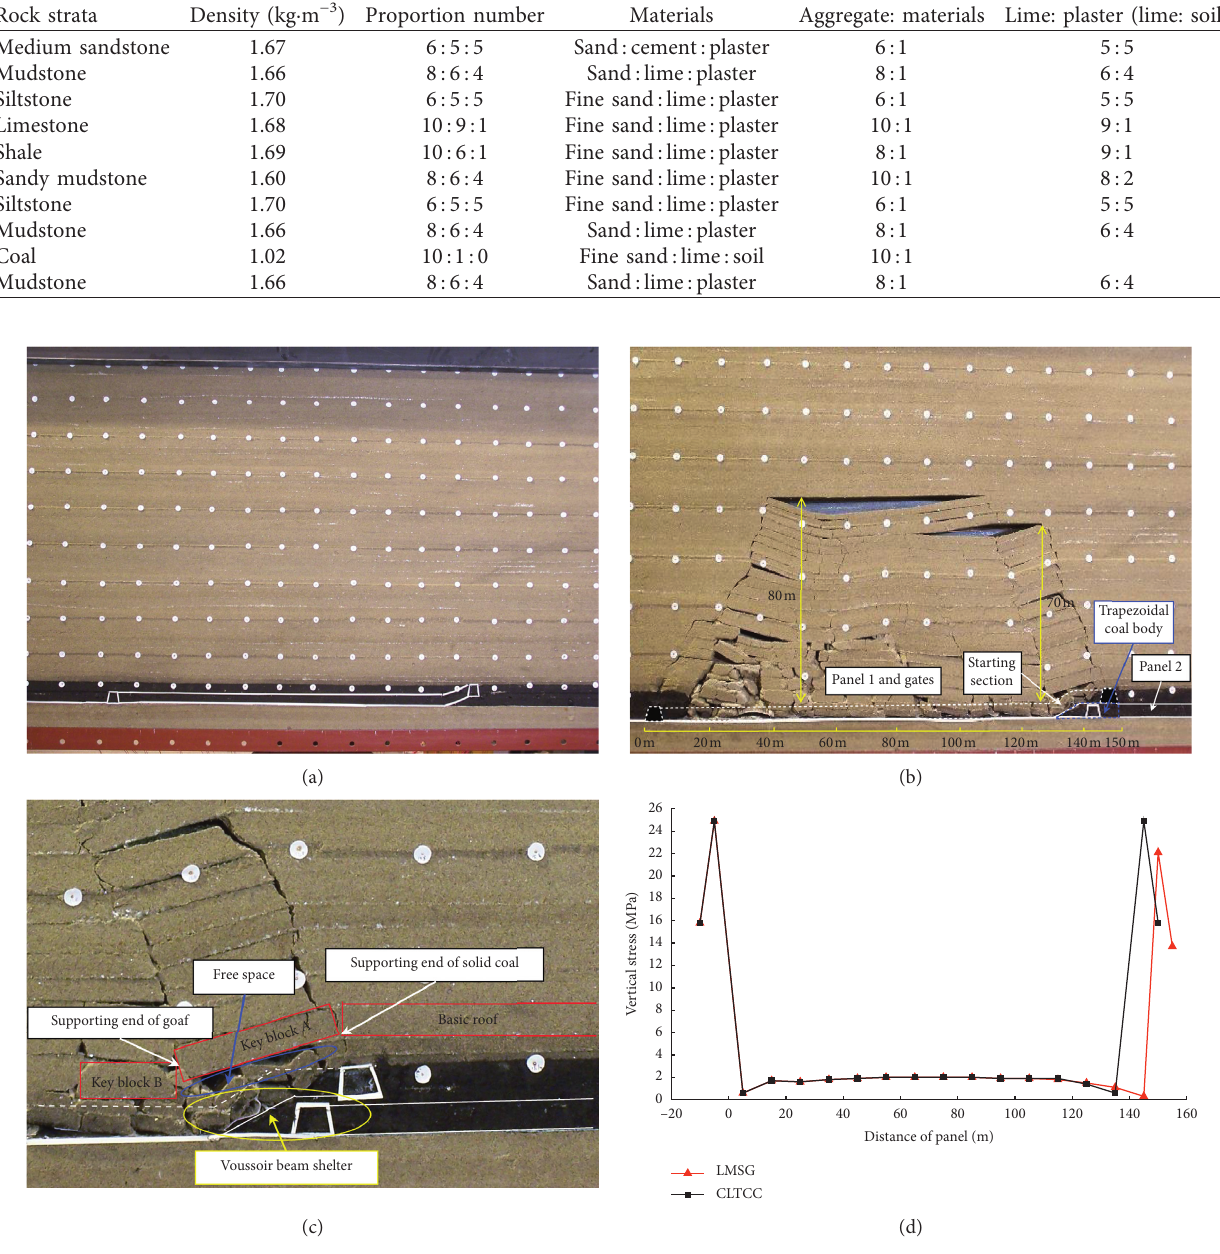
Table 2: Material parameters and proportion of different constituents in physical model materials.